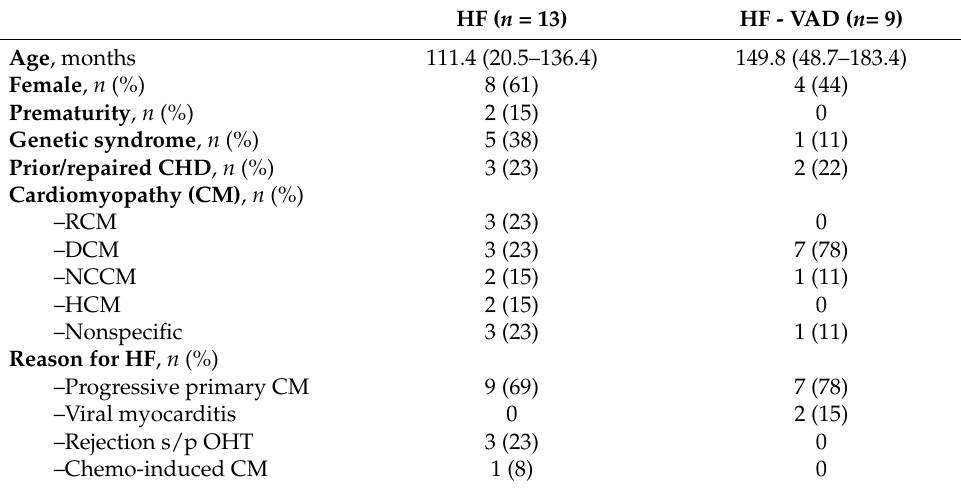
Table 1. Demographics. Congenital heart disease (CHD), restrictive cardiomyopathy (RCM), dilated cardiomyopathy (DCM), noncompaction cardiomyopathy (NCCM), hypertrophic cardiomyopathy (HCM), and orthotopic heart transplant (OHT).